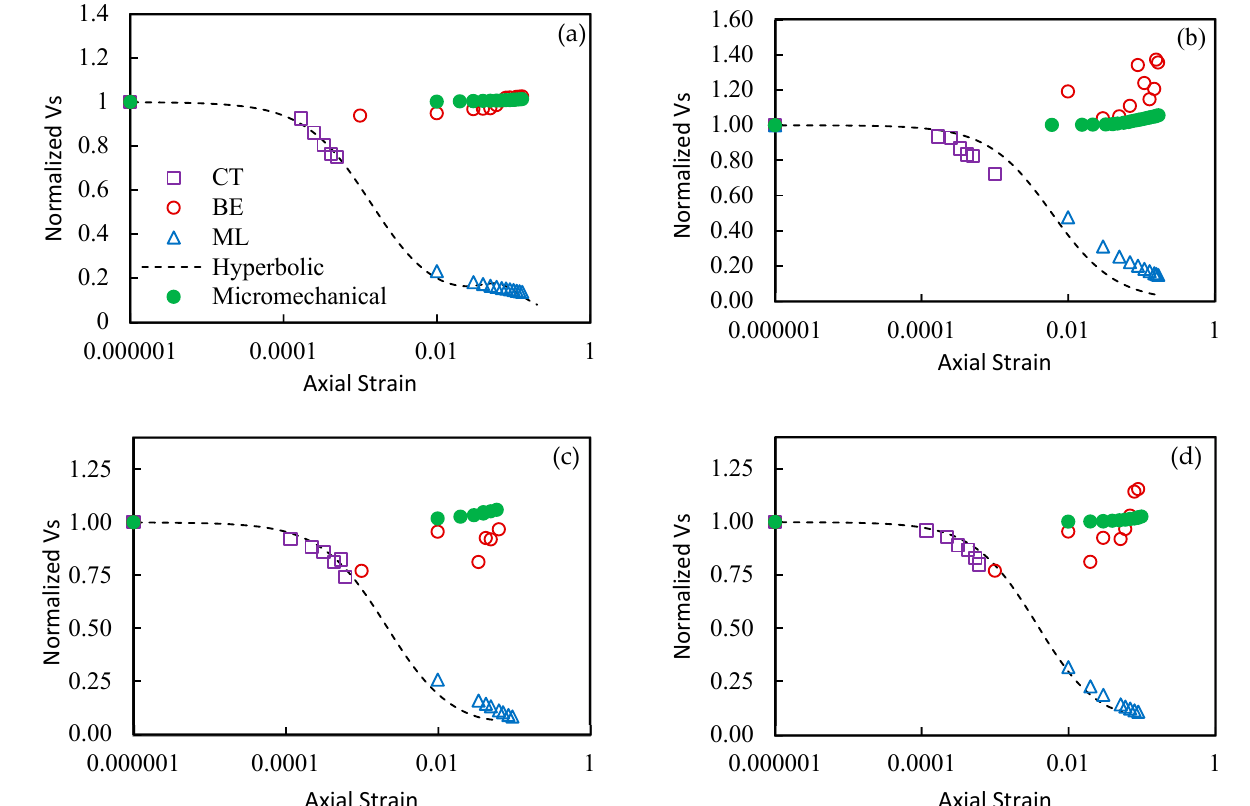
Figure 8. Variation of normalized Vs from cyclic triaxial (CT), bender elements (BE), and stress–strain curve of monotonic loading (ML) for ( a ) sample A at 150 kPa, ( b ) sample A at 300 kPa, ( c ) sample B at 150 kPa, and ( d ) sample B at 300 kPa.